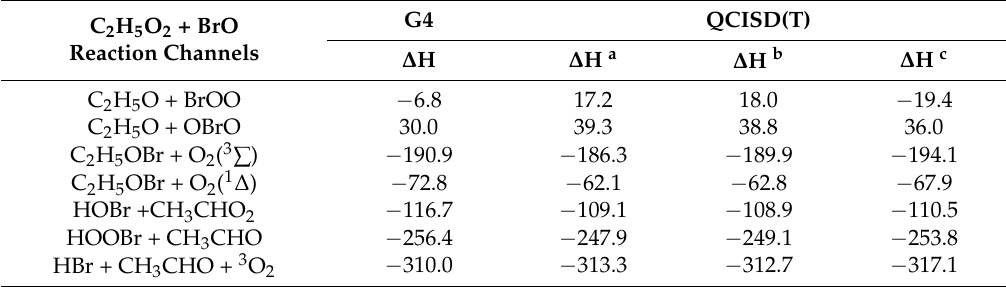
Table 1. The reaction enthalpies ( ∆ H) (in kJ/mol) of several channels in the C 2 H 5 O 2 + BrO reaction obtained form at the various levels of theory. C 2 H 5 O 2 + BrO